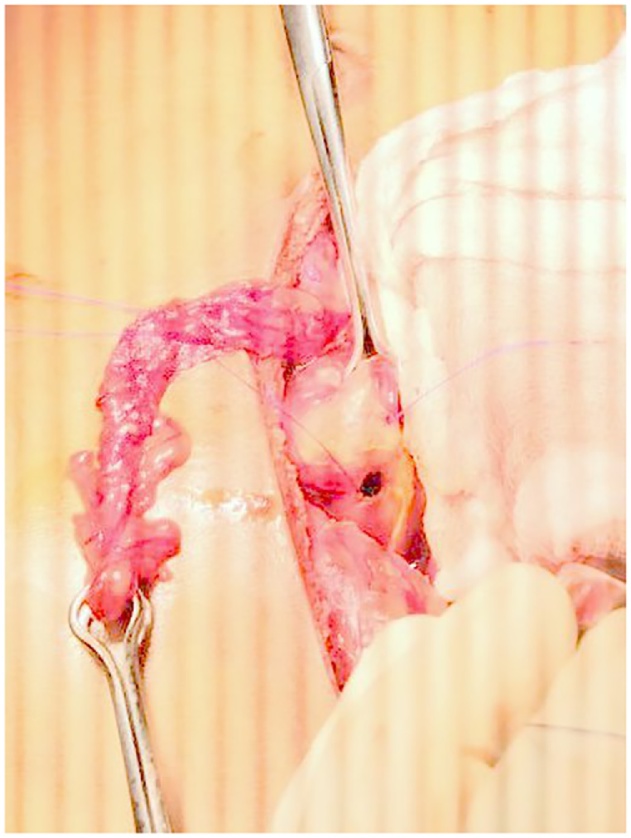
1 × 1 cm gastric antrum perforation with a tailored omental tongue.